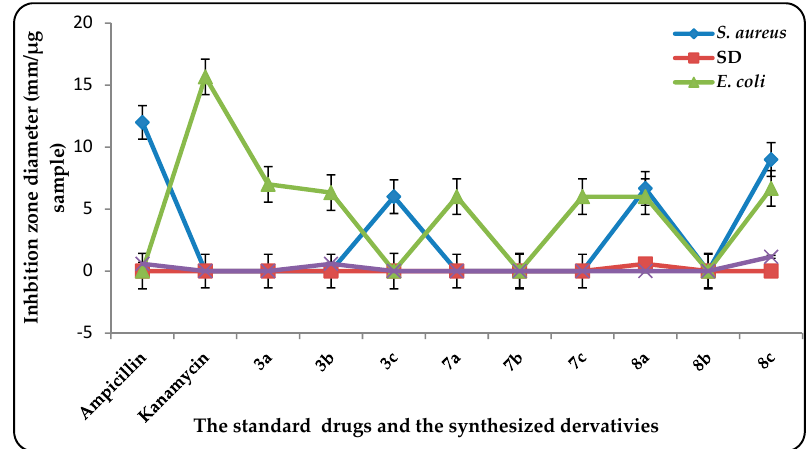
Figure 1 Antimicrobial activity of the tested benzimidazole derivatives vis-à-vis selected pathogenic Figure 1. Antimicrobial activity of the tested benzimidazole derivatives vis- à -vis selected pathogenic bacteria strains comparing with standard drugs. bacteria strains comparing with standard